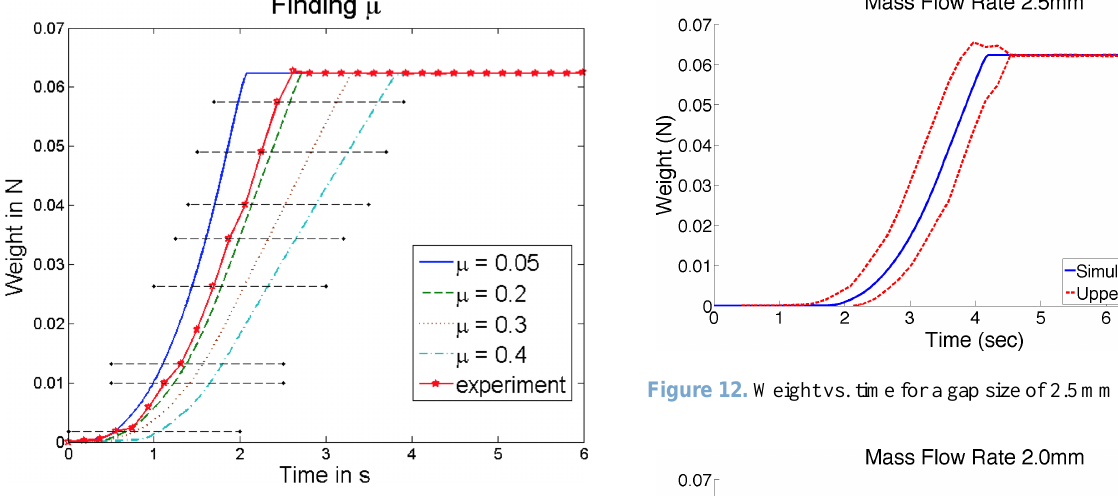
Figure 10. Selection of µ .